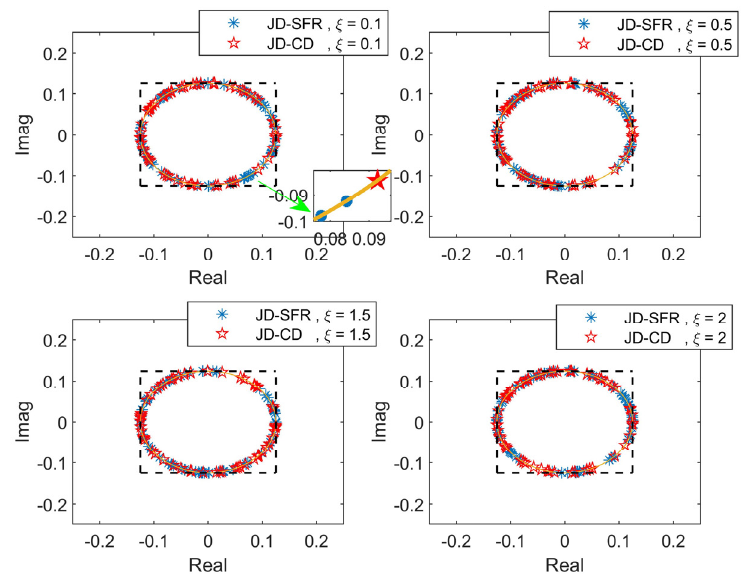
Figure 9. Amplitude characteristics of designed waveforms under different similarity parameters.